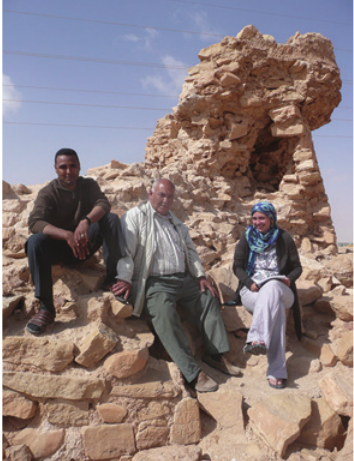
Figure 6 Corisande Fenwick and colleagues in Libya, 2011 (Source: photo- graph by Corisande